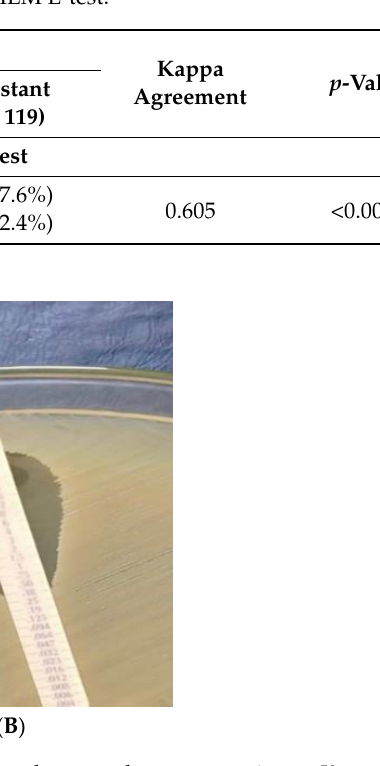
Table 3. Correlation between VITEK2 compact and MEM E-test.